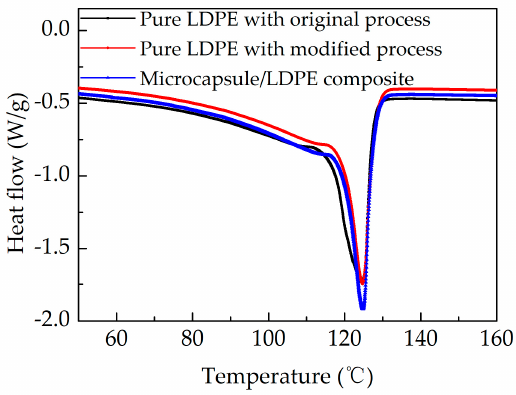
Figure 5. Heat flow curves of samples.